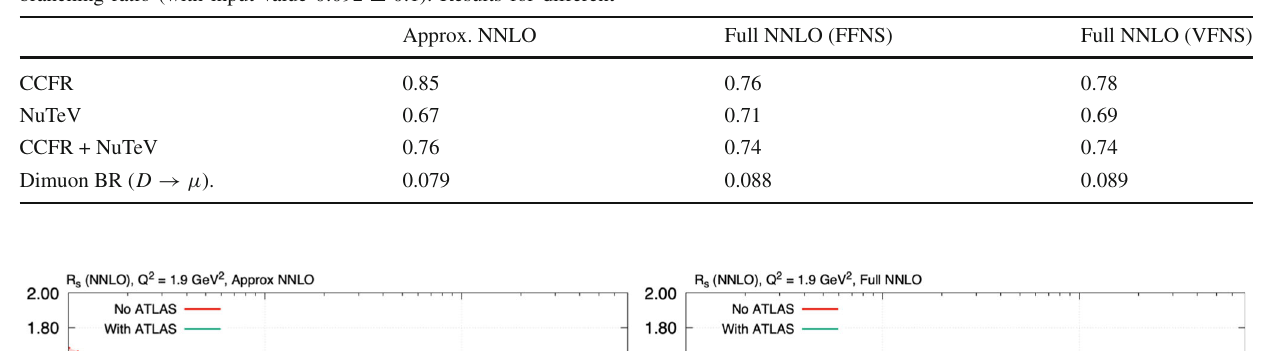
Table 13 χ 2 / N pts for neutrino-induced dimuon production data in MSHT NNLO fits ( α S free), as well as the corresponding D → μ branching ratio (with input value 0 . 092 ± 0 . 1). Results for different